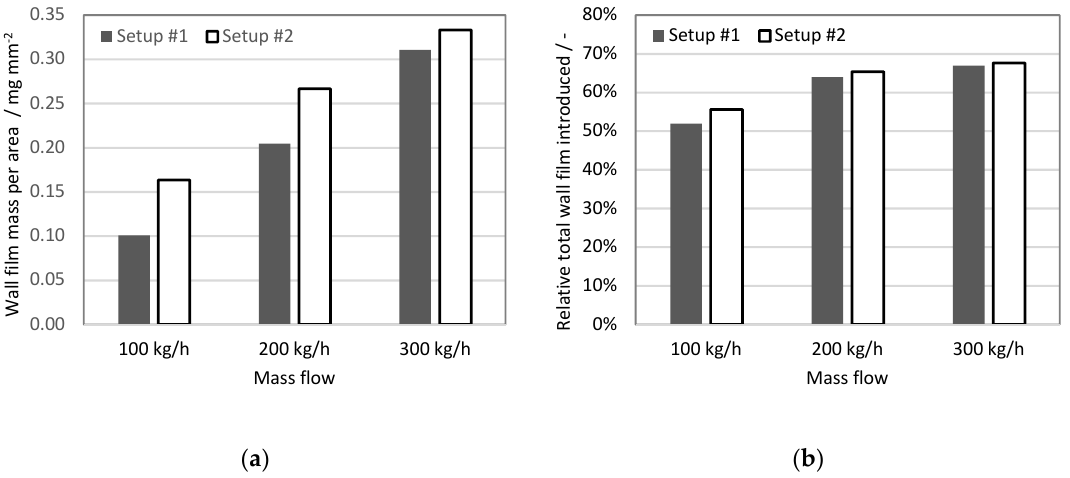
Figure 12. Wall film analysis: ( a ) wall film mass to wall film area ratio at the end of 4th injection cycle; ( b ) relative total wall film mass introduced (normalized by the total mass injected).